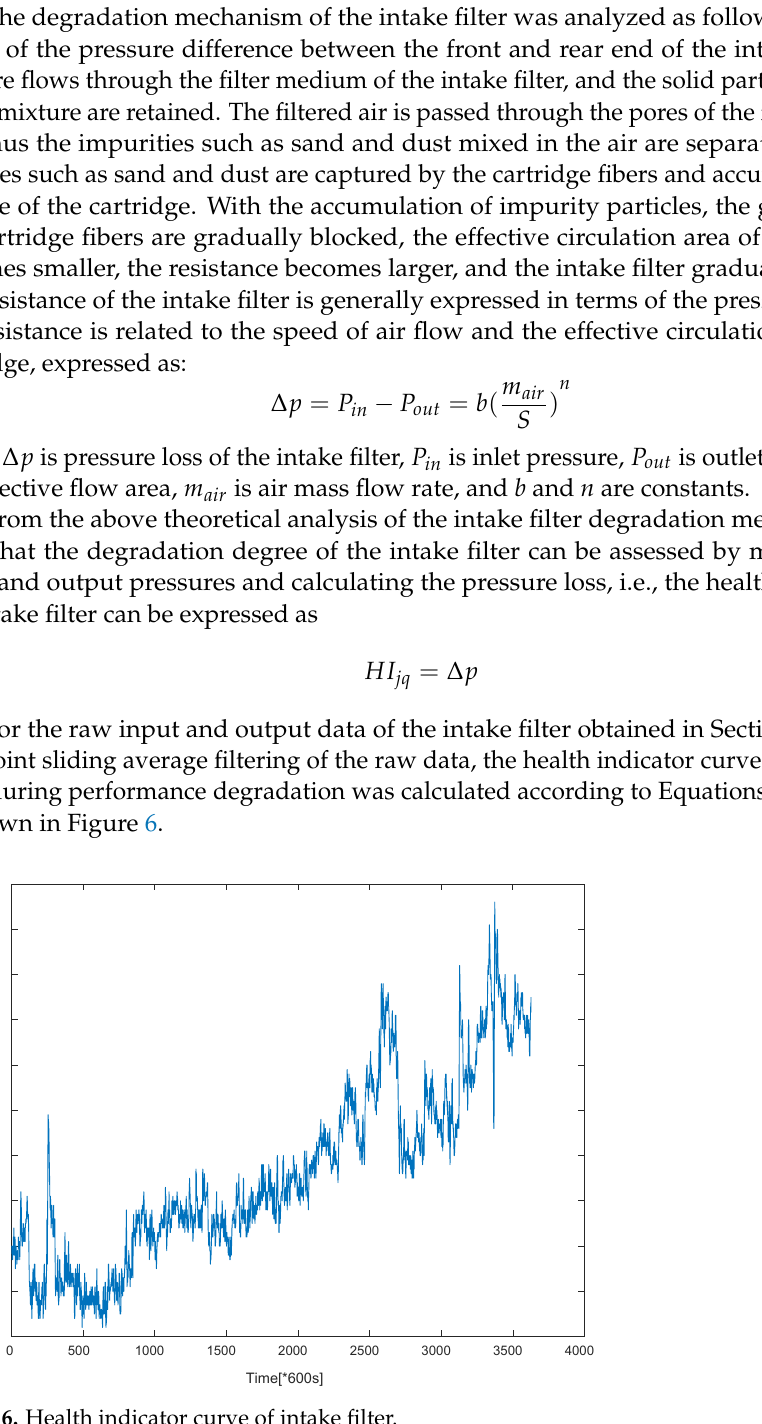
Figure 6. Health indicator curve of intake filter.